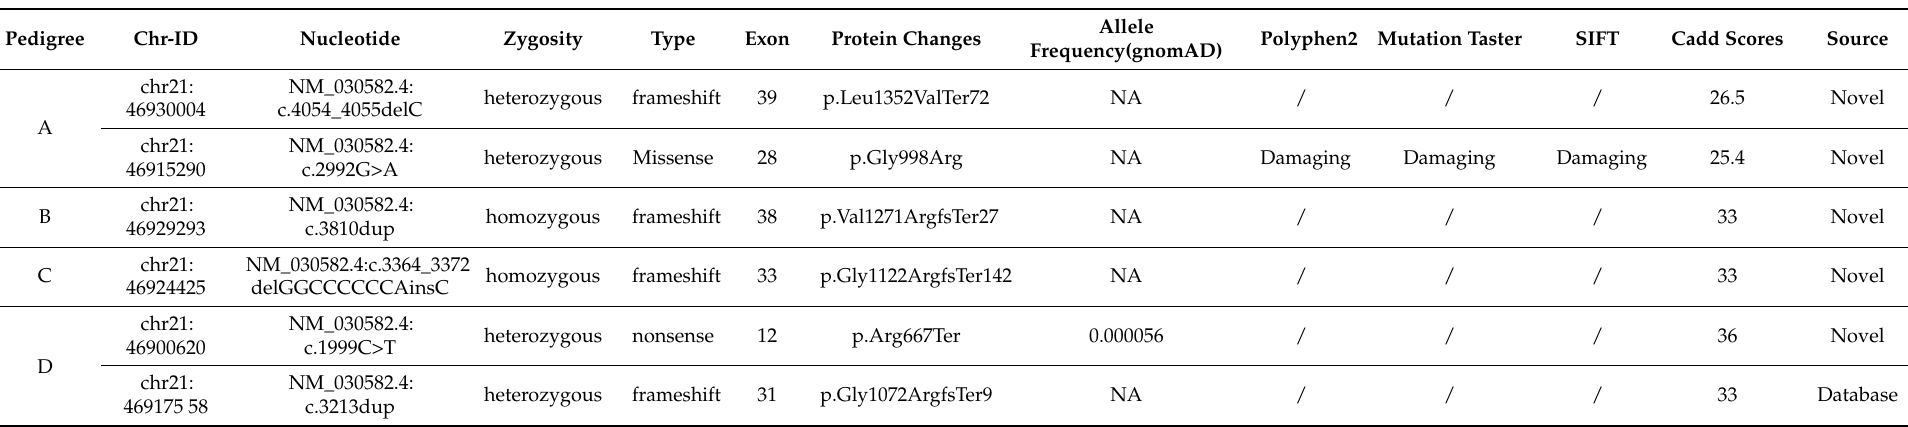
Table 2. Clinical features of the KS